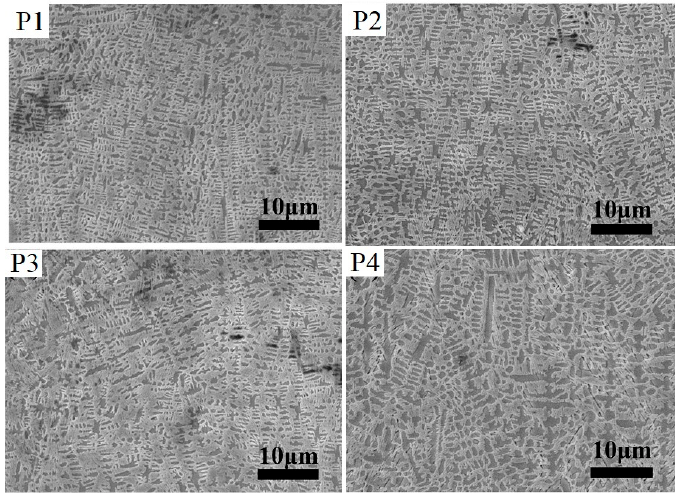
Figure 7. Photographs of cross section shapes of four different biomimetic unit combinations. The section of the bionic unit body is composed of the melting zone, transition zone, and base metal.